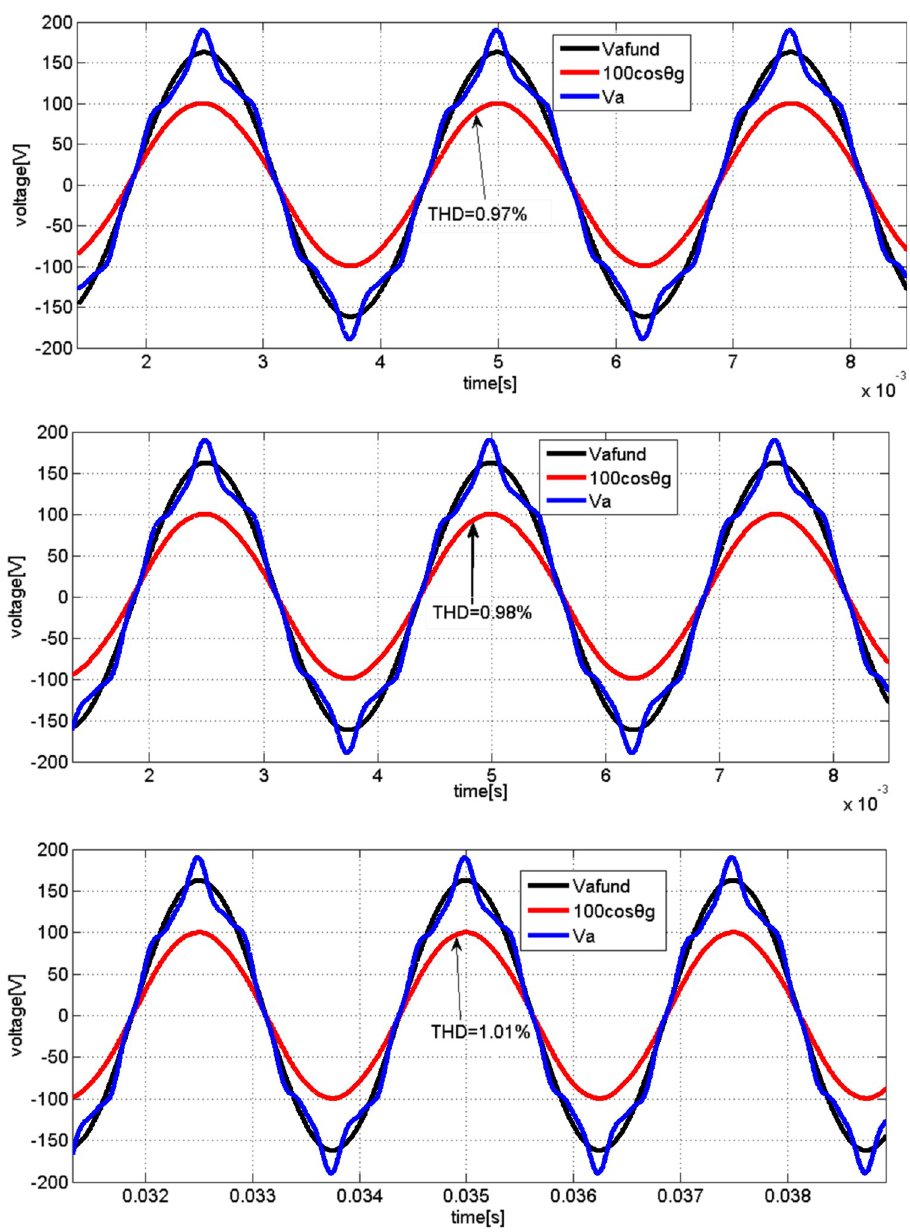
Fig 7. Simulation results of cos θ g under three